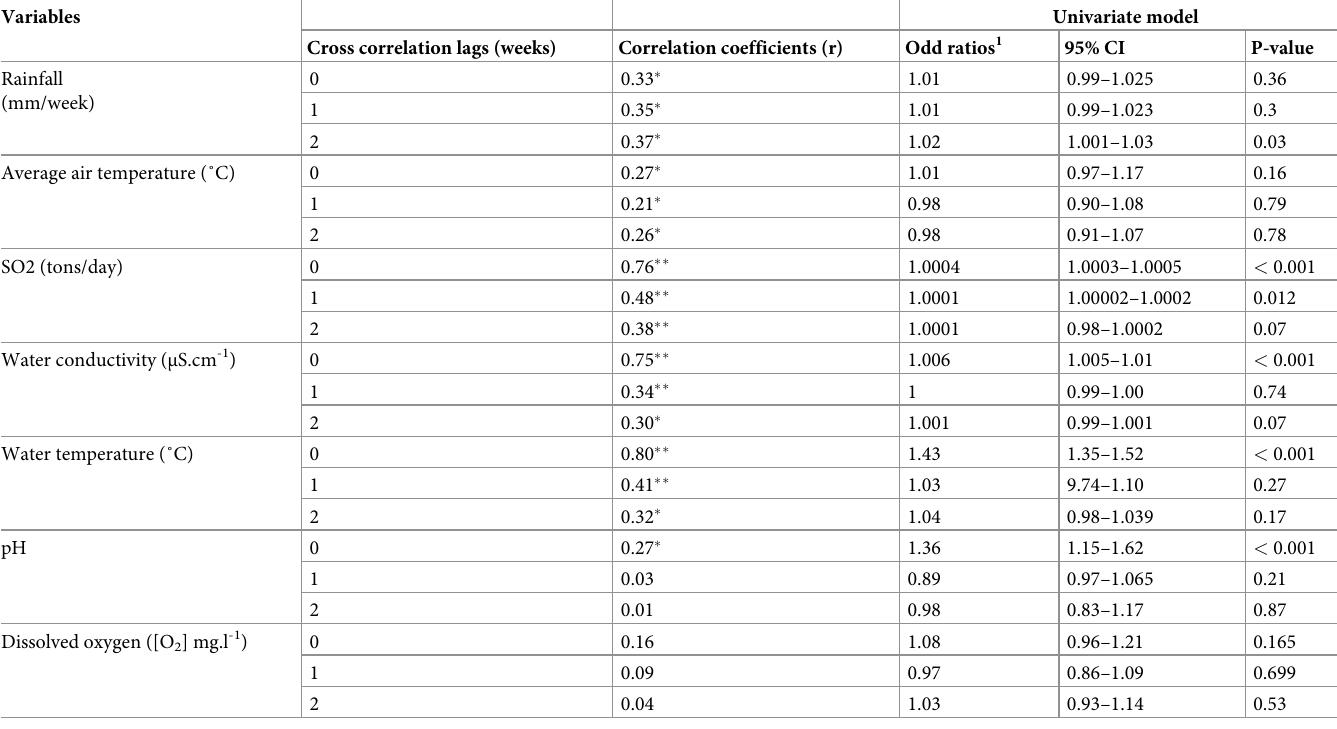
Table 3. Cross-correlation coefficients and univariate model of logarithmic transformation of observed number of cholera cases and environmental variables over the 2007–2012 period (n = 147 sampled